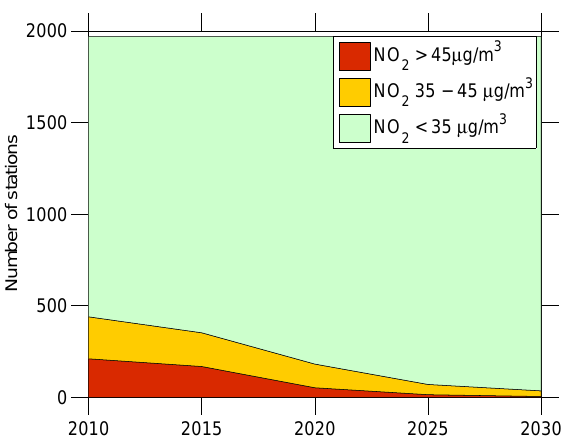
Fig. 11. Projected NO 2 compliance under current legislation: num- bers of stations in the different compliance categories, EU-28